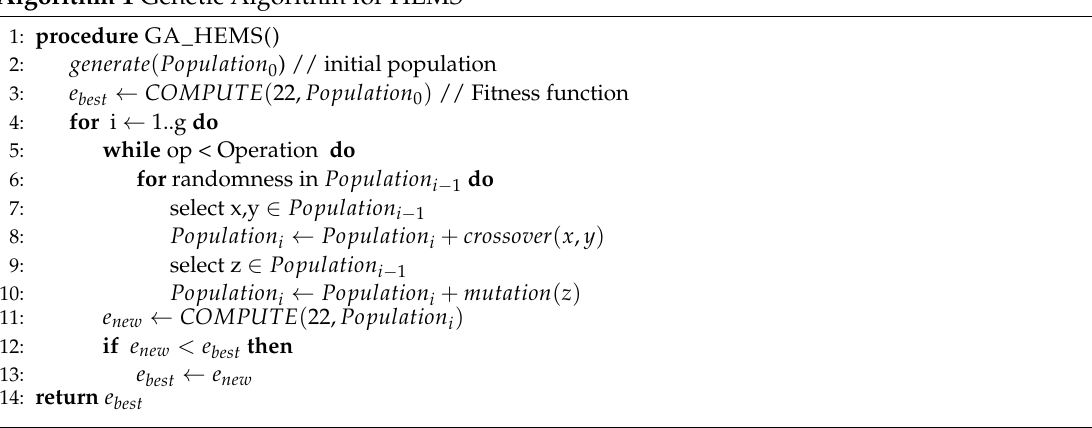
Algorithm 1 Genetic Algorithm for